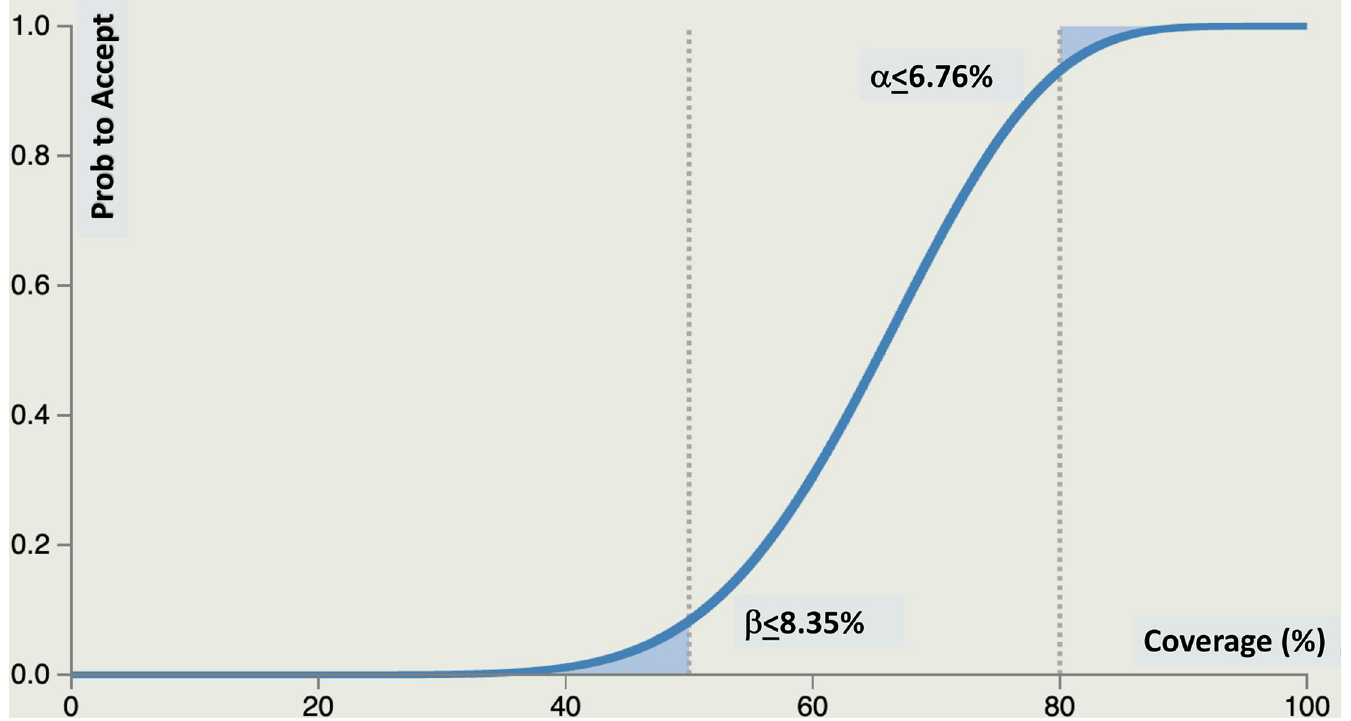
Fig 1. Operating characteristic curve for p U = 0.80, p L = 0.50, d = 13 showing the probability of being classified as reaching p U .